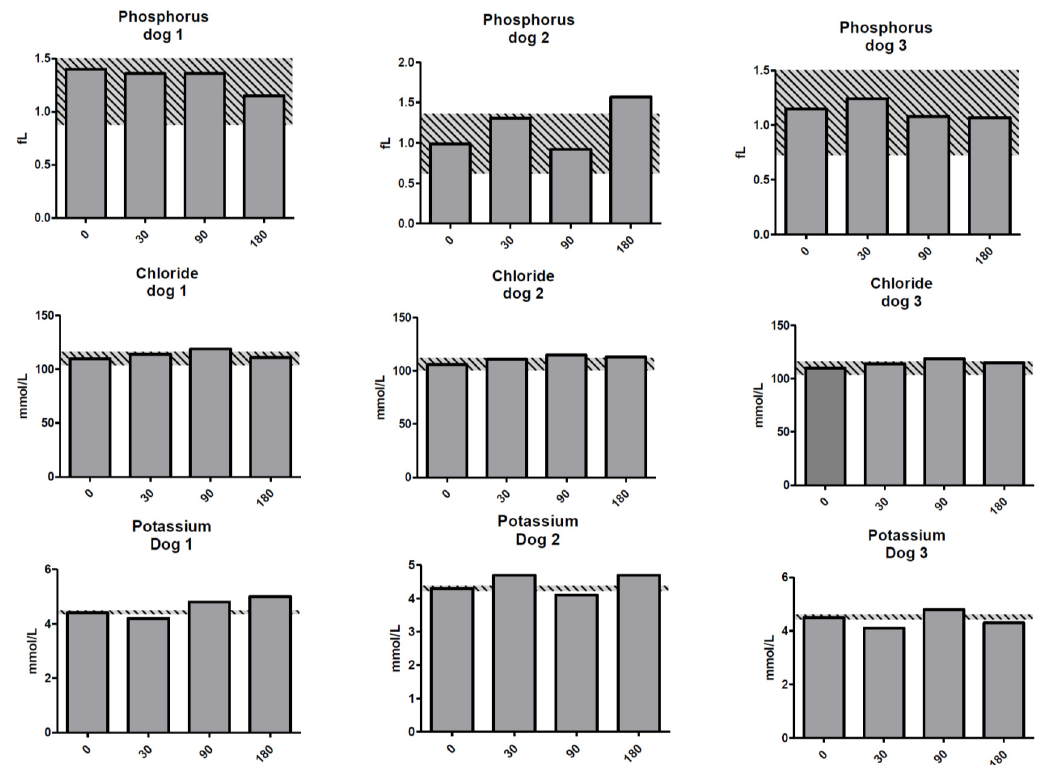
Figure 5. Phosphorus, chloride, and potassium for the dogs on days 0–180 post treatment with 213 Bi-400-2 antibody. Upper row—phosphorous; middle row—chloride; lower row—potassium. Shaded areas show reference change values (RCVs). X axis shows days post injection of radiolabeled antibody.